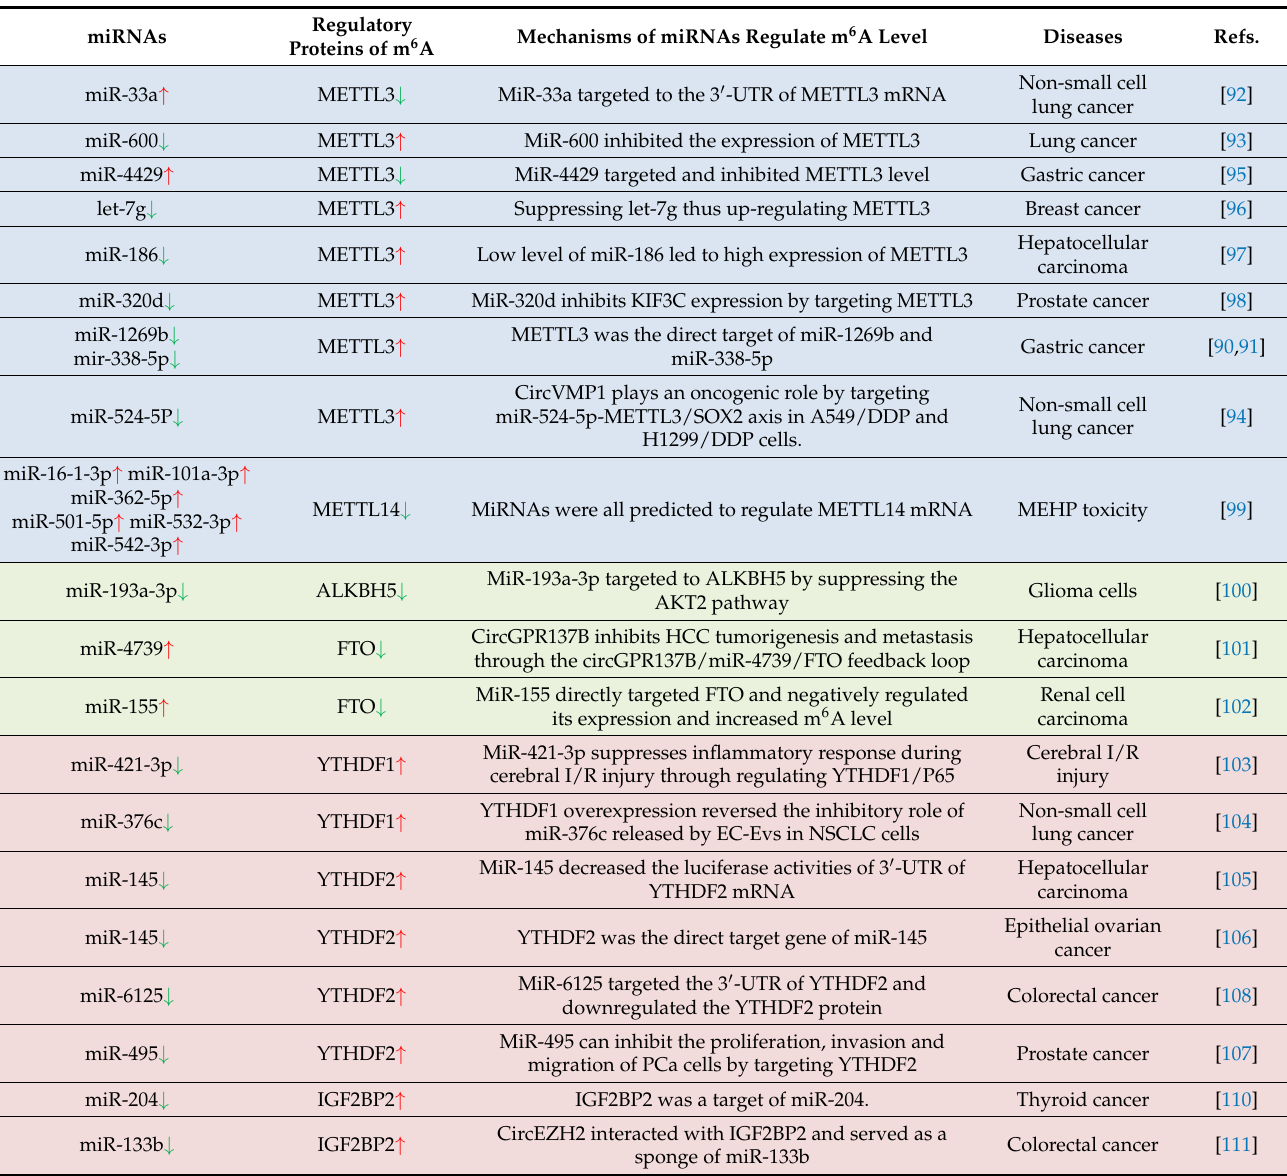
Note: Sections of table with blue, green and pink background describe the process of miRNA production regulated by methyltransferases, demethylases and methyl-binding proteins, respectively. The red upward arrow represents the elevation of expression, and the green downward arrow indicates the reduction of